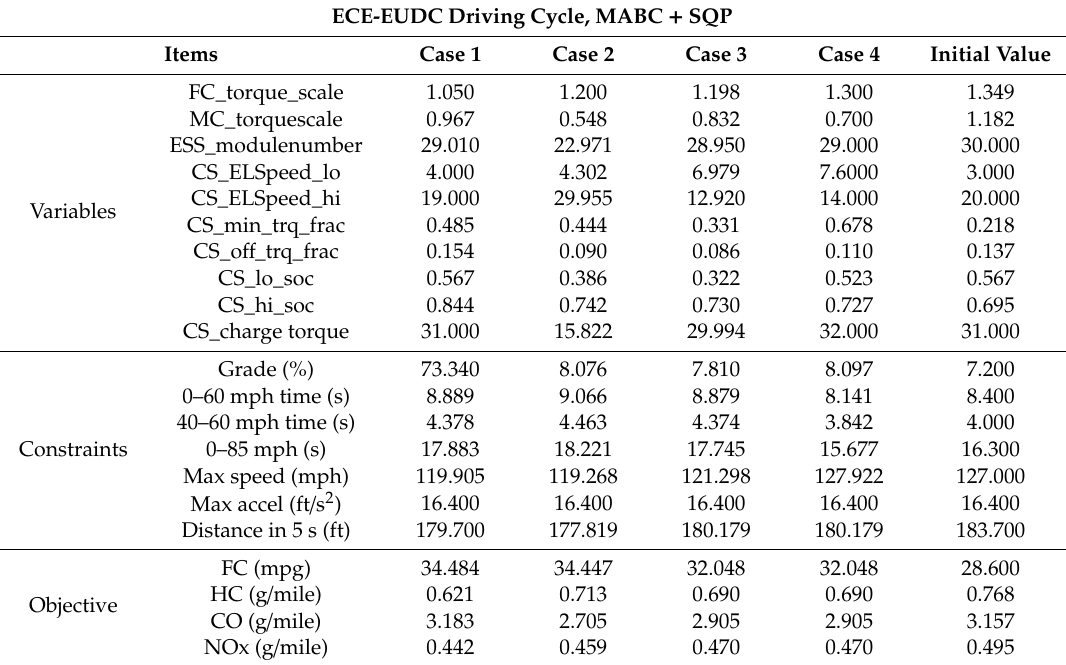
Table 6. Results of ECE-EUDC driving cycle for MABC + SQP.